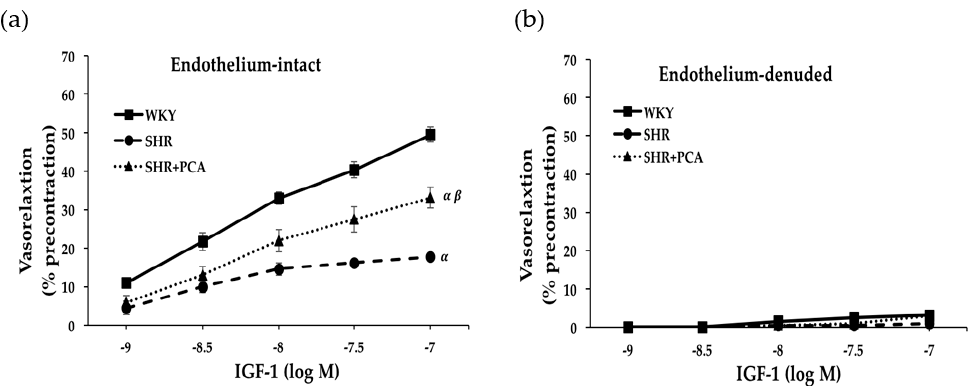
Figure 2. Insulin-like growth factor-1 (IGF-1; 10 − 9 to 10 − 7 M)-induced vasorelaxation at cumulative concentration–response curves in ( a ) endothelium-intact and ( b ) endothelium-denuded aortic rings among the WKY, SHR, and SHR+PCA groups. α , p < 0.05, significant differences from WKY; β , p < 0.05, significant differences from SHR; n = 8 in each group.